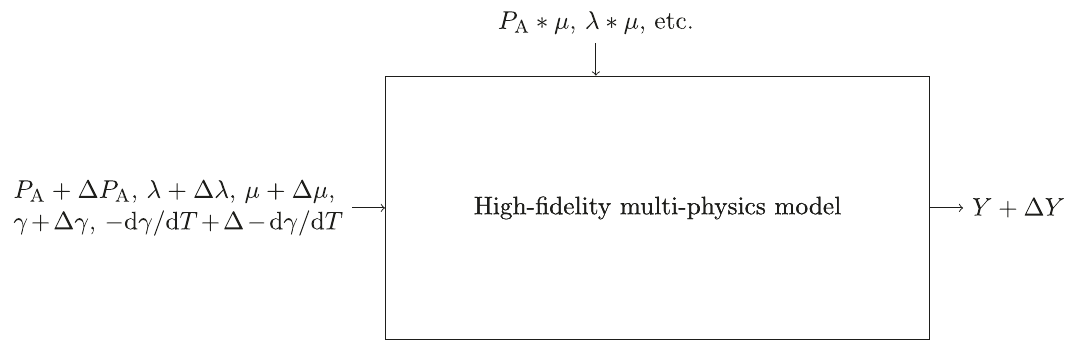
Fig. 7 A black box representation of the propagation of uncertainty Δ , from the input parameters ( P A , λ , μ , γ , − d γ /d T ) to the output ( Y ) in a high- fi delity multi-physics